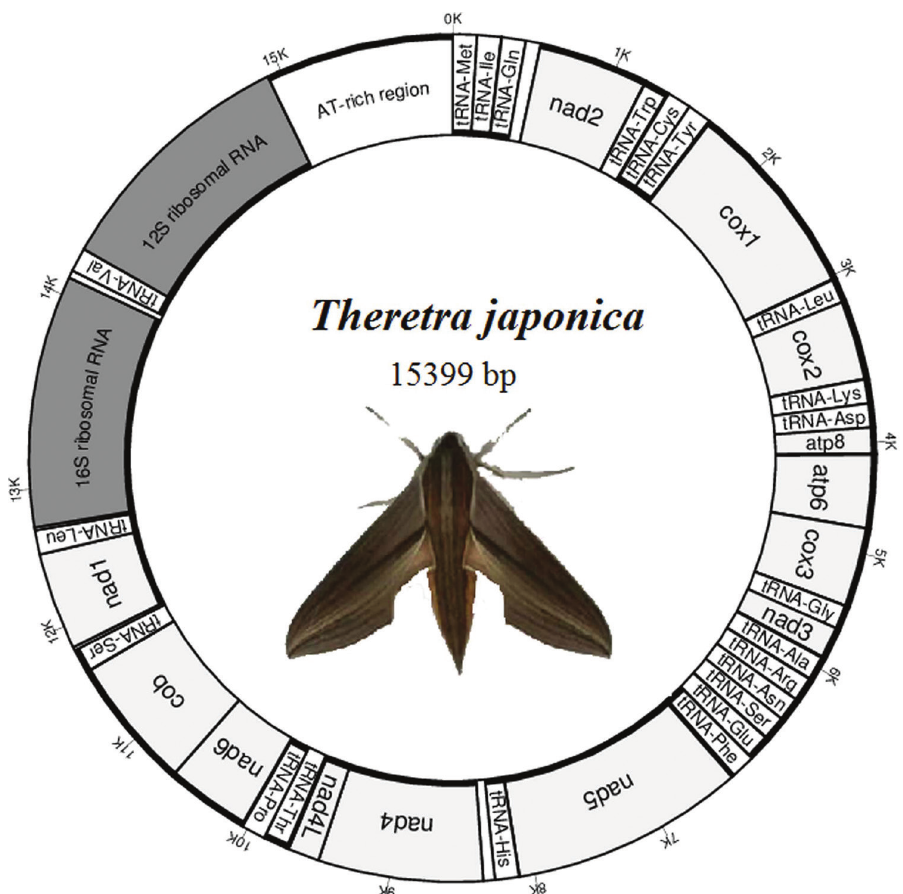
Figure 1. The schematic illustration for mitogenome of T. japonica . Gene order and positions are shown. cox1 , cox2, and cox3 refer to the cytochrome c oxidase subunits; cob refers to cytochrome b ; nad1-nad6 refers to NADH dehydrogenase components; rrnL and rrnS refer to ribosomal RNAs. The bold lines on outer or inner ring represent that the genes lie in the majority-coding strand (J-strand) or the minority- coding strand